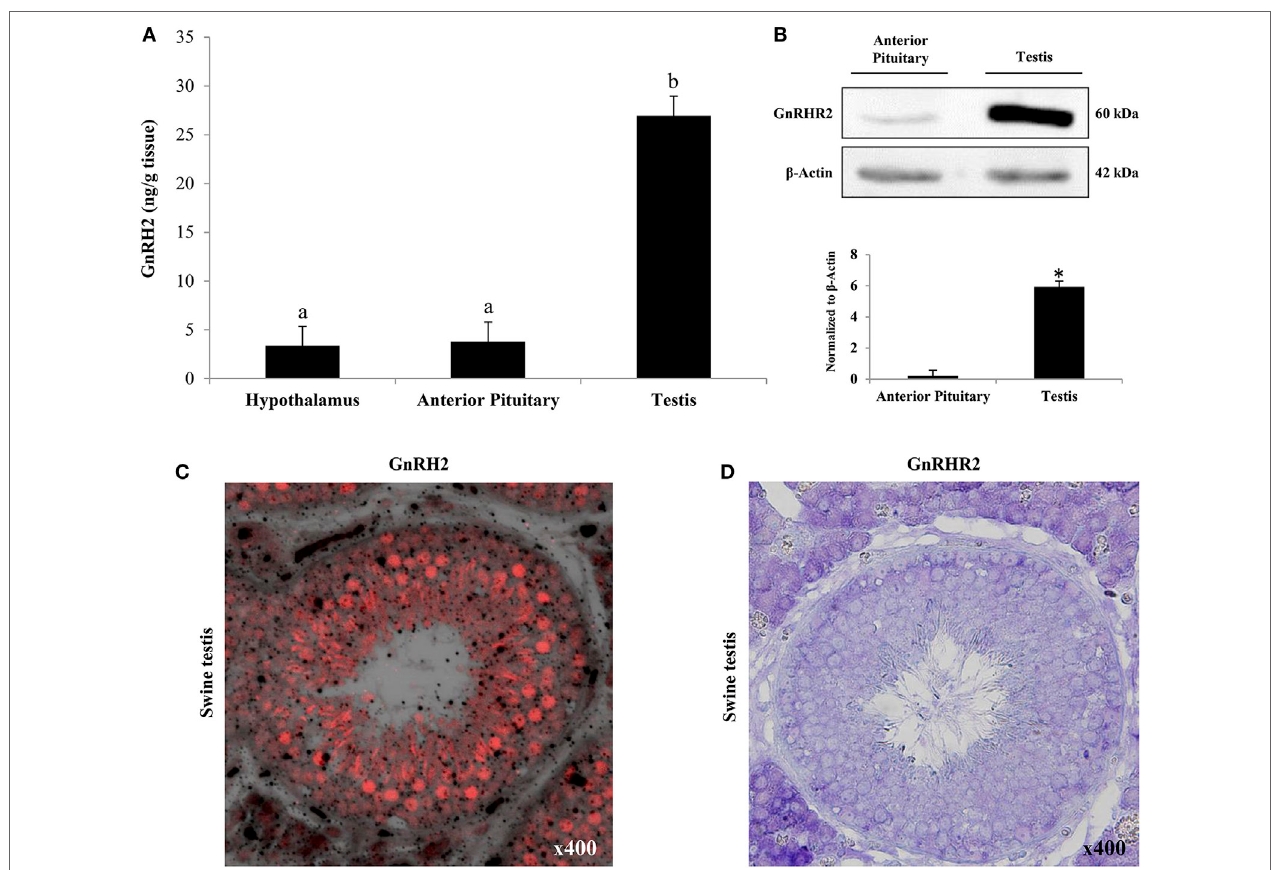
FiGURe 5 | Both GnRH2 and GnRHR2 are abundantly produced within the porcine testis. (A) GnRH2 levels were determined via ELISA of homogenates from the hypothalamus, anterior pituitary gland, and testis of males ( n = 6). a,b Bars with alternate letters differ ( P < 0.0001). (B) Representative western blot of anterior pituitary gland and testicular tissue from boars ( n = 5) using an antibody directed against GnRHR2 (upper panel). Immunoblot quantification revealed a difference in GnRHR2 protein levels between tissue types (* P < 0.0001; lower panel). (C) GnRH2 is primarily localized to the tubular compartment of the porcine testis. Representative immunofluorescence image (400 × ; merge of fluorescence and transmitted light) of porcine testes ( n = 5) using an antibody directed against GnRH2 (red). (D) GnRHR2 localizes to both the tubular and interstitial compartments of the porcine testis. Representative immunohistochemistry image (400 × ) of porcine testes ( n = 7) using an antibody directed against GnRHR2 (purple). Reprinted from Desaulniers et al. (35) with permission from Oxford University